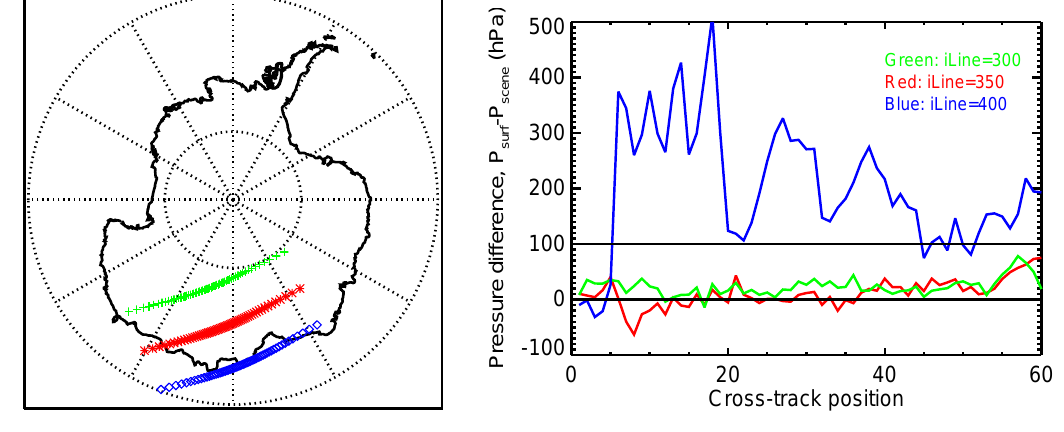
Fig. 1. Left: three OMI scan lines (iLine = 300, 350, and 400) over Antarctica for OMI orbit 12394 on 13 November 2006. Right: difference between surface pressure, P surf , and retrieved scene pressure, P scene , (pressure of a Lambertian surface that provides the observed amount of rotational-Raman scattering – see text for details) for these scan lines as a function of OMI cross-track position.